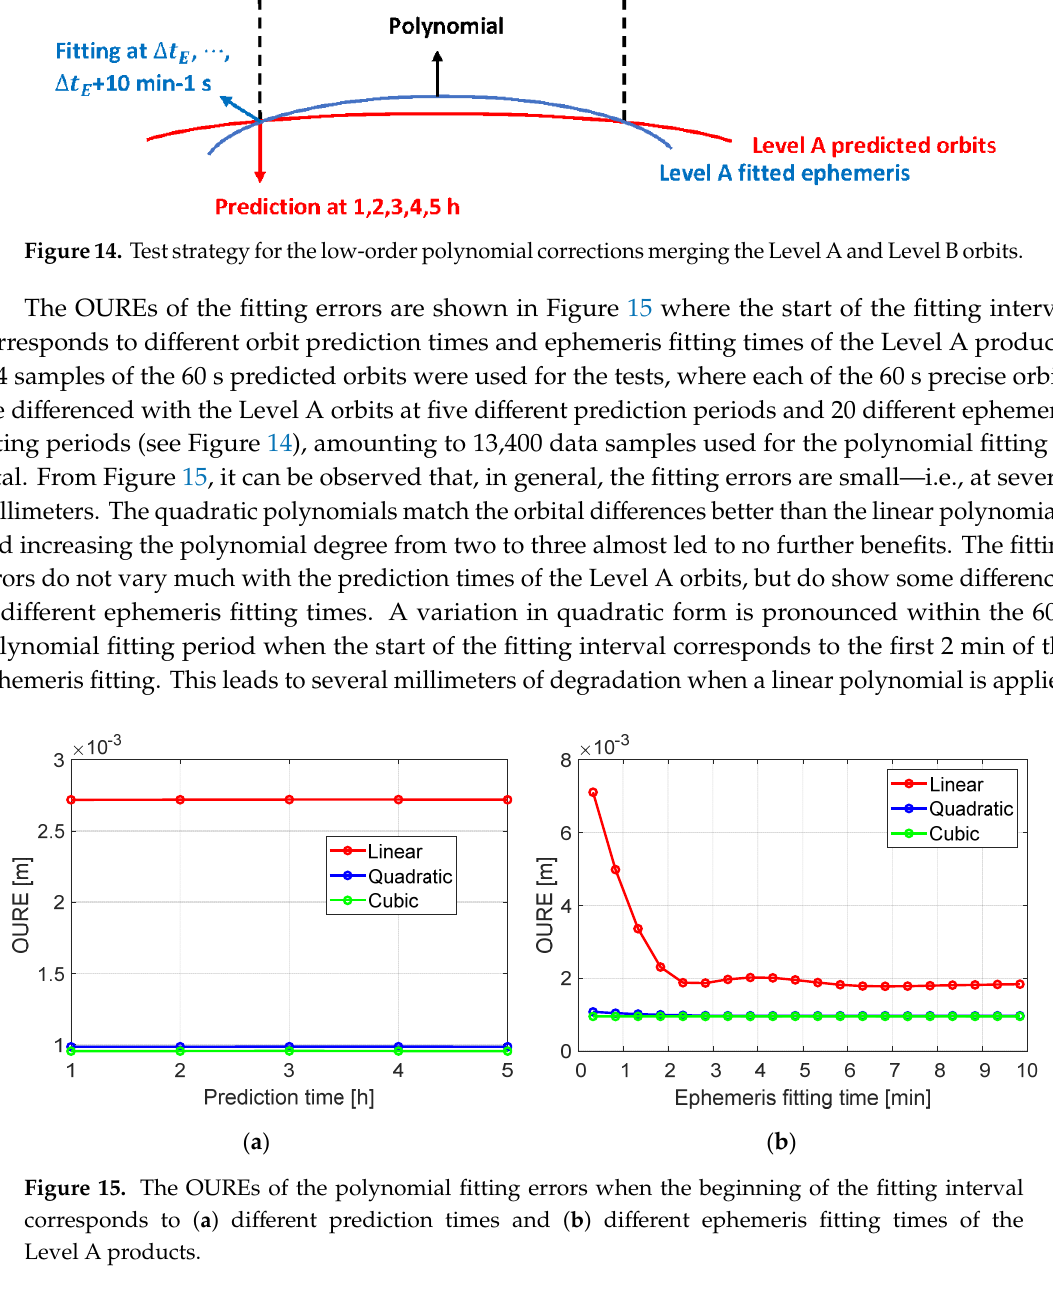
( b ) Figure 16. The OURE of ( a ) the polynomial fitting errors and ( b ) the total Level B orbital errors concerning the polynomial fitting time. The total error budget of the Level B orbital products are given in Table 8 at the beginning and the end of the polynomial fitting. It can be observed that the prediction errors still play a major role in the total error budget, while increasing the polynomial degree from one to two can reduce the fitting OUREs by a few millimeters. Further increasing the polynomial degree does not lead to obvious benefits in fitting the OUREs. In general, the Level B orbits have an accuracy of a few centimeters and can fulfil the requirement for single-receiver high-precision positioning service. Increasing the polynomial degree from one to two or three does not have significant influences on the total error budget of the Level B products.